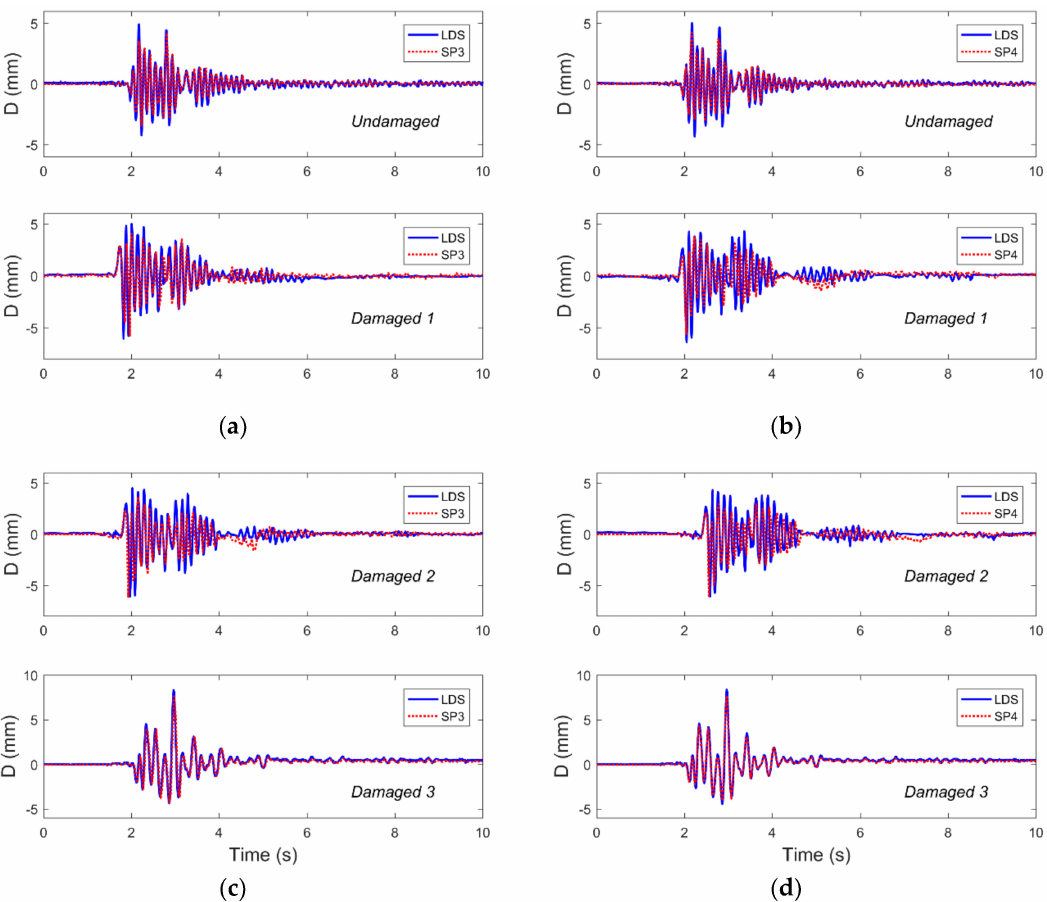
Figure 7. The displacement time-history responses as collected by the LDSs (laser displacement sensors) and SPs with Nr-1 cm excitation for four damage cases are compared and found to show good agreement. Representative results are shown from ( a ) frame 1 and ( b ) frame 2 in the undamaged case and damaged 1 case, as well as from ( c ) frame 1 and ( d ) frame 2 in the damaged 2 and 3